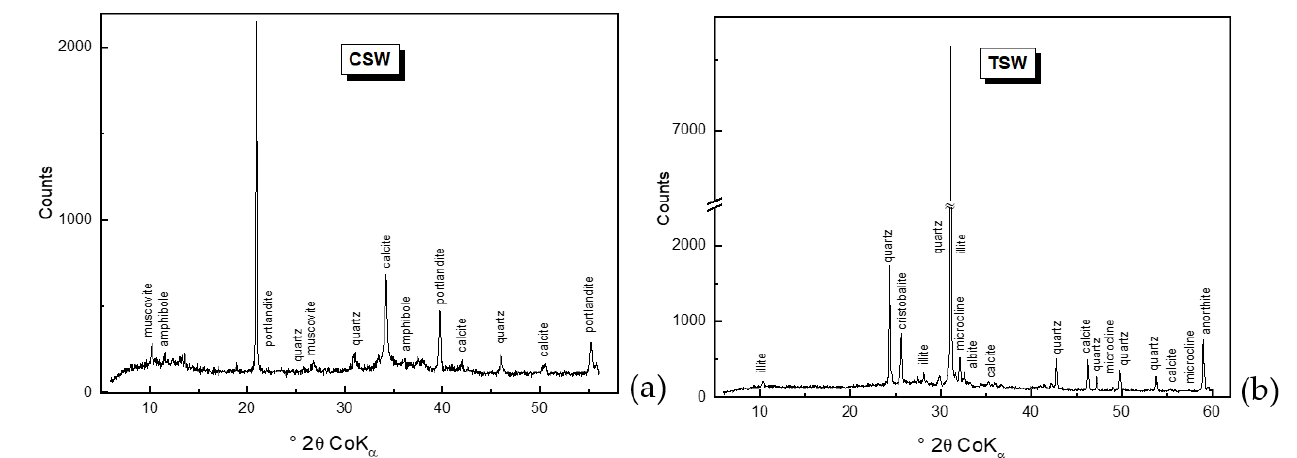
Figure 1. XRD patterns of building wastes. ( a ) Concrete Slurry Waste, (CSW), ( b ) Technical Stone Waste (TSW). During the surface modification, hydrated Fe 3+ particles in reactive ion-exchangeable form occupied binding positions on the CSW/TSW surface, creating anion-active adsorption sites. The final products (CSW Fe and TSW Fe ) represented a brown-coloured homogeneous sorbent with a different pH ZPC , associated with a different adsorption affinity for anionic contaminants (Figure 2).